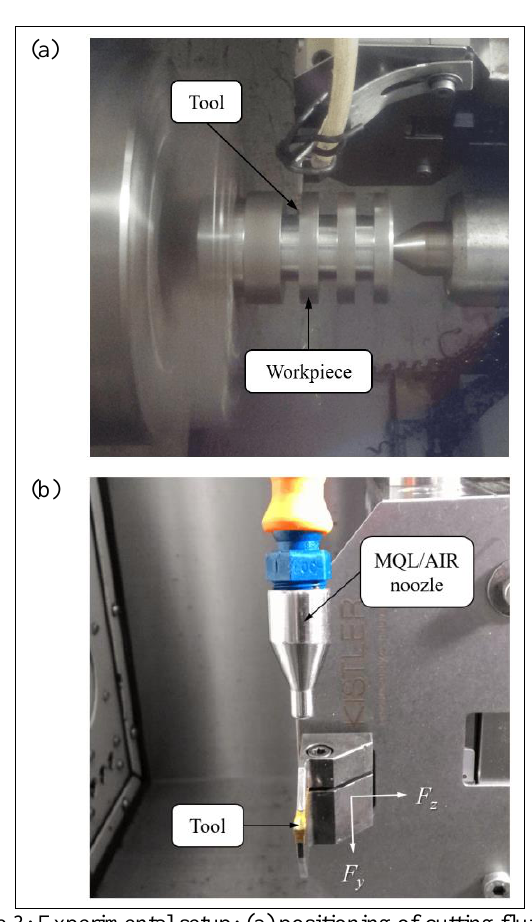
Figure 3: Experimental setup: (a) positioning of cutting fluid hose for WET machining; (b) MQL/AIR nozzle